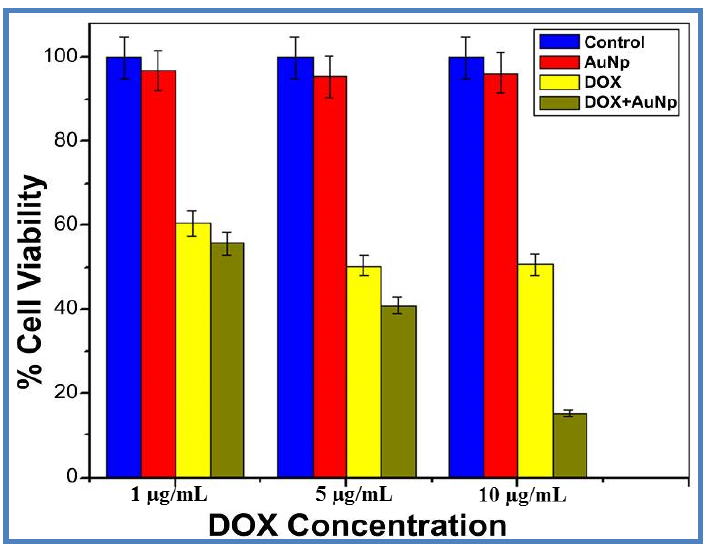
Figure 5. Cytotoxicity of free and AuNPs loaded DOX in Hela cells. HeLa cells (5 × 10 3 cells) were seeded in 96 well plates and after 70% confluency treated with different concentrations of DOX or DOX loaded AuNPs in phosphate buffered saline (PBS) and grown for further 24 h. Cell viability was determined by MTT assay. Data is expressed is mean ± S.D. where n =